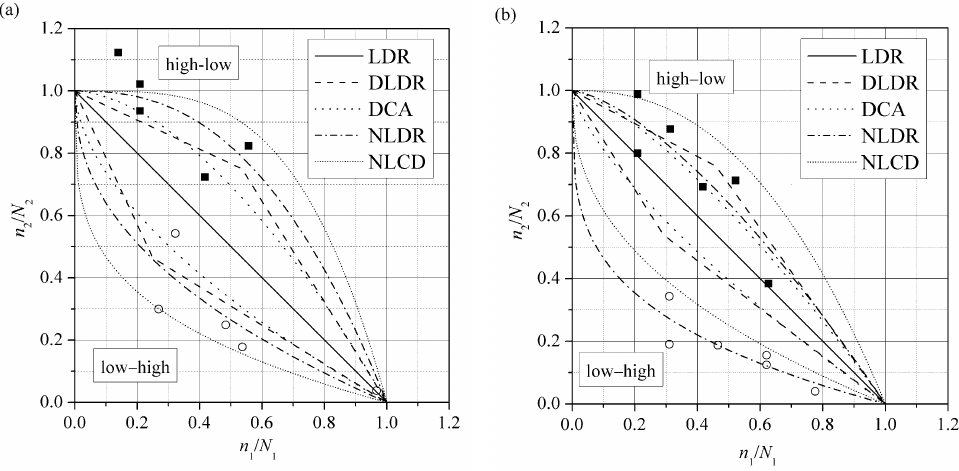
Figure 6. Test results and predicted damage fractions under ( a ) 647/517 MPa and ( b ) 595/517 MPa.